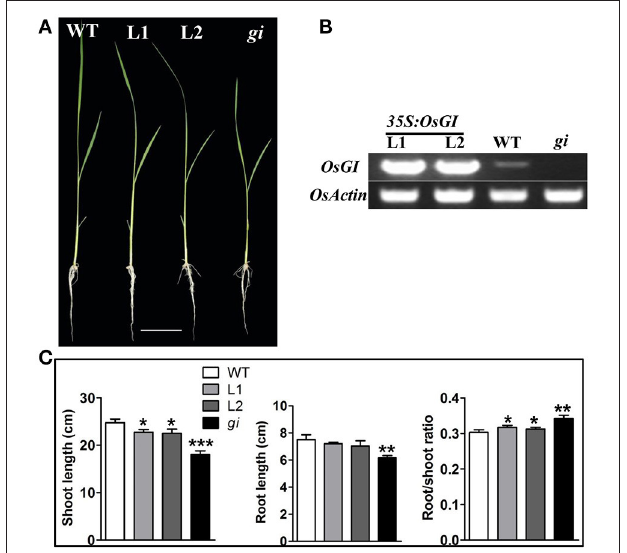
FIGURE 2 | Characterization of the growth phenotype in osgi -complemented plants. (A) WT, osgi mutant ( gi ) and two OsGI -complemented osgi mutant lines (L1 and L2) grown hydroponically under normal conditions for 14 days. (B) OsGI expression in WT, osgi , L1 or L2 plants 4 h after lights-on measured by RT-PCR. Plants were grown under normal conditions for 14 days. (C) Comparison of shoot length, root length and root/shoot ratio of WT, L1, L2 and osgi plants. All data represent the mean of three biological replicates, with error bars indicating SD. Significant differences relative to the corresponding WT strain are indicated with asterisks ( *** P < 0.001; ** P < 0.01; and * P < 0.05). Bars = 4cm.